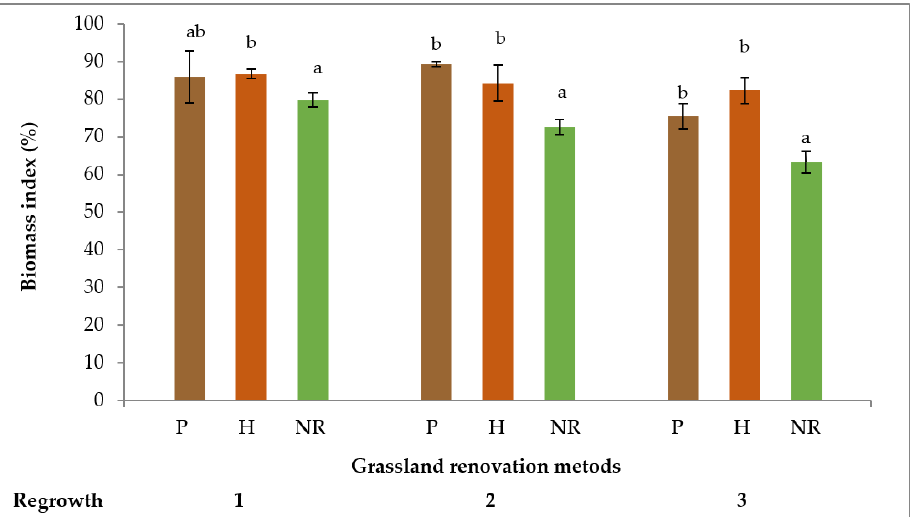
Figure 3. Three-year averages of biomass index (%) by grassland renovation method and by regrowth. P, ploughing; H, harrowing; NR, non-renovated (control treatment). The same letter above a column means no significant difference between the means.